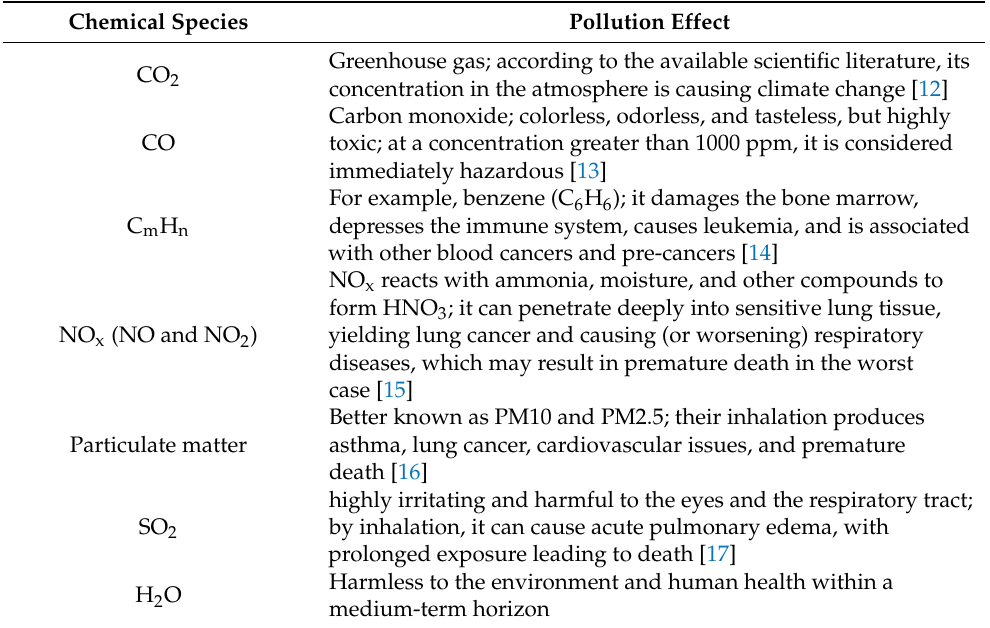
Table 1. Main exhaust gases emitted by conventional combustion processes. Chemical